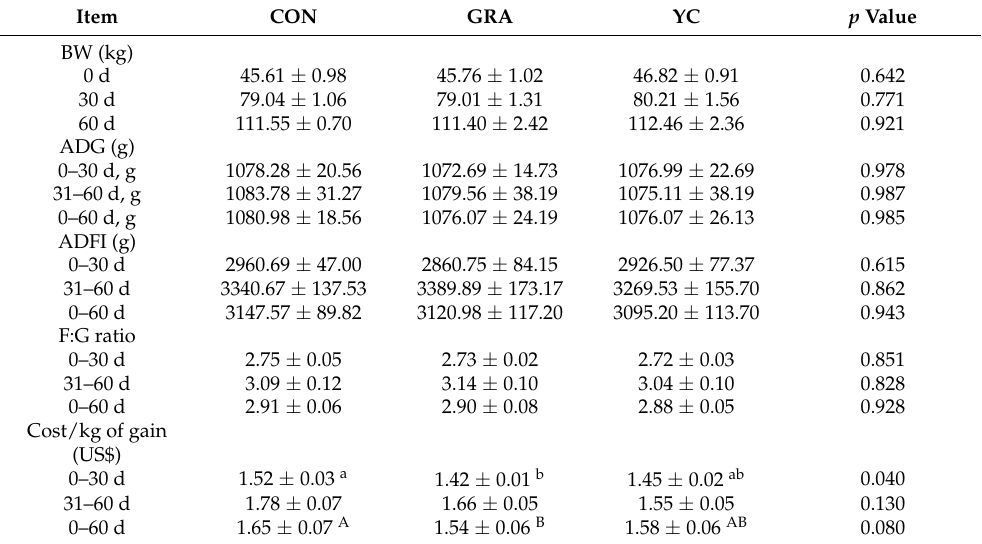
Table 3. Effect of dietary yeast culture supplementation on growth performance of finishing